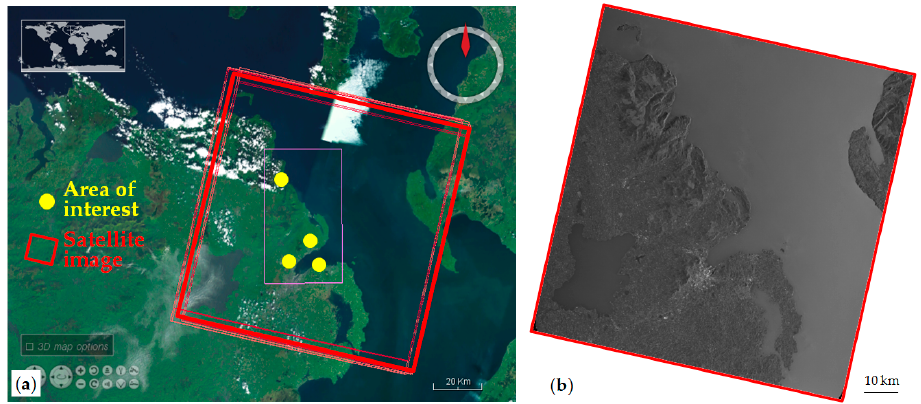
Figure 4. ( a ) Location of the areas of interest and satellite image footprints, and ( b ) average Synthetic Aperture Radar (SAR) amplitude of the ERS-1/2 data stack. ERS-1/2 data © European Space Agency (ESA) 2016.